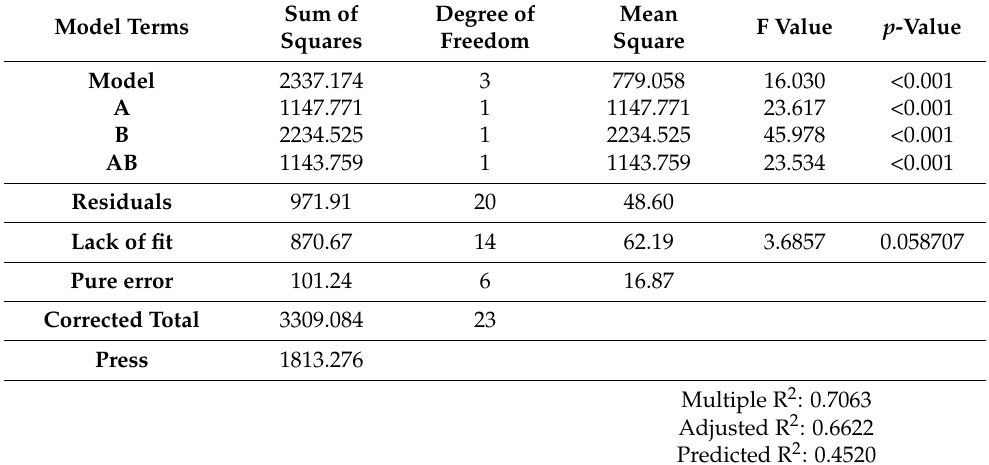
Table 3. ANOVA and regression analysis summary for the thin-walled tubes’ total thickness.